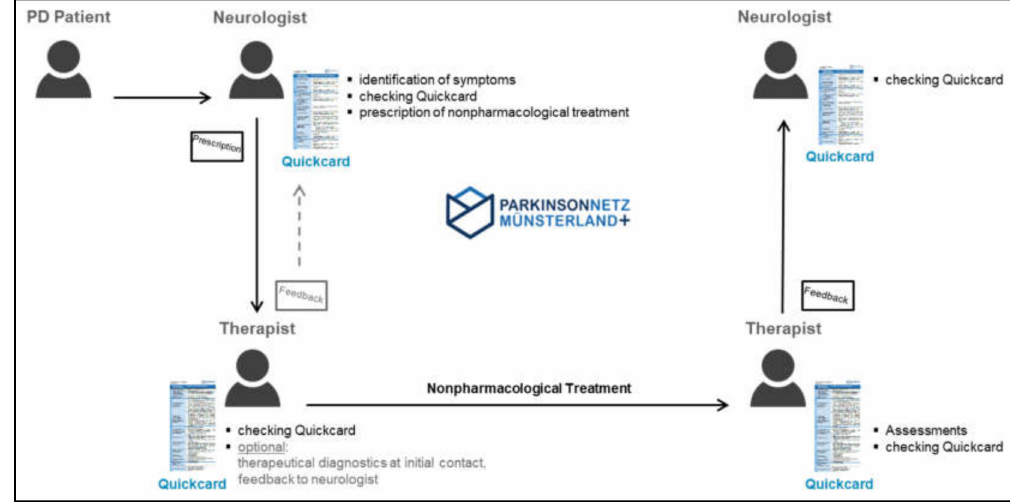
Figure 1. Schematic representation of an interdisciplinary treatment process using